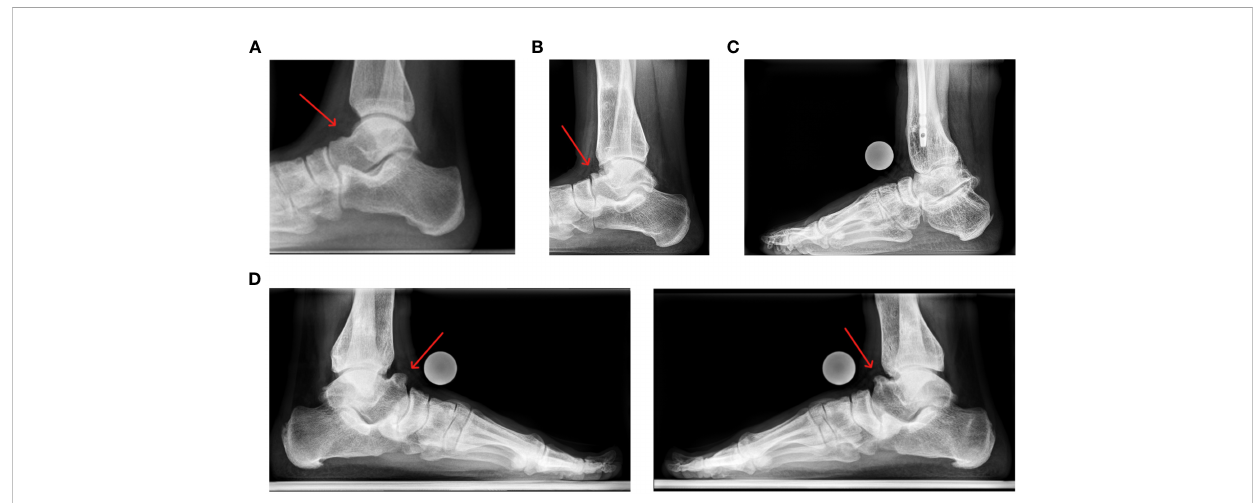
FIGURE 6 Lateral view of the ankle joint: (A) 21 year old female patient presenting with a minor anterior talar osteophyte development; (B) 19 year old female patient presenting a severe anterior talar osteophyte. (C) Lateral left ankle of a 32 year old male patient, state after numerous tibial and femoral osteotomies with OA and osteophytes of the tibia and talus. (D) lateral feet of a 30 year old male patient, state after multiple prior surgeries of both lower limbs. The patient is currently pain free but reports restricted ankle dorsi fl exion.